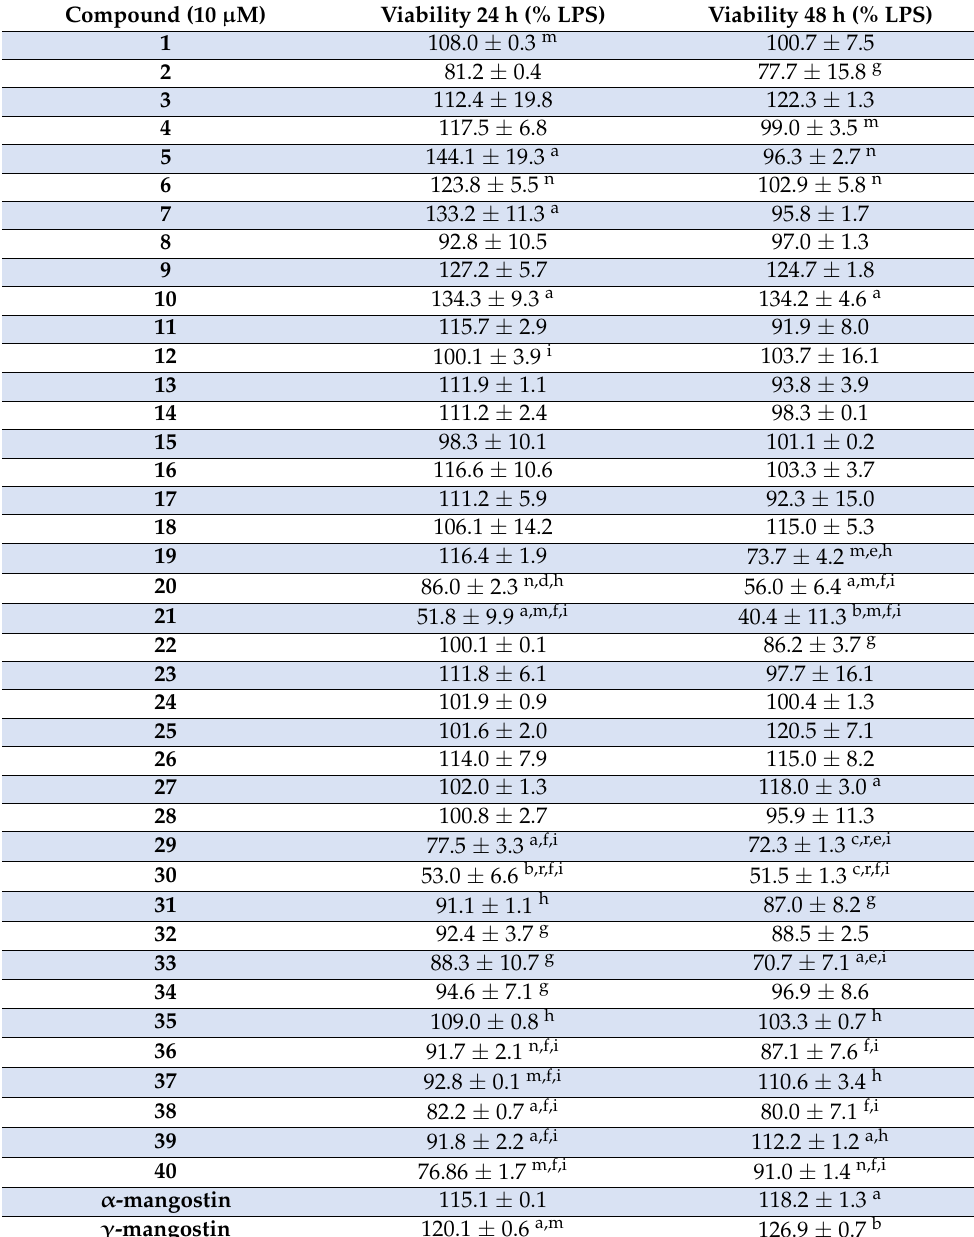
Table 3. Cell metabolic activity percentages in the presence of compounds 1 – 40 at 10 µ M obtained from the MTT